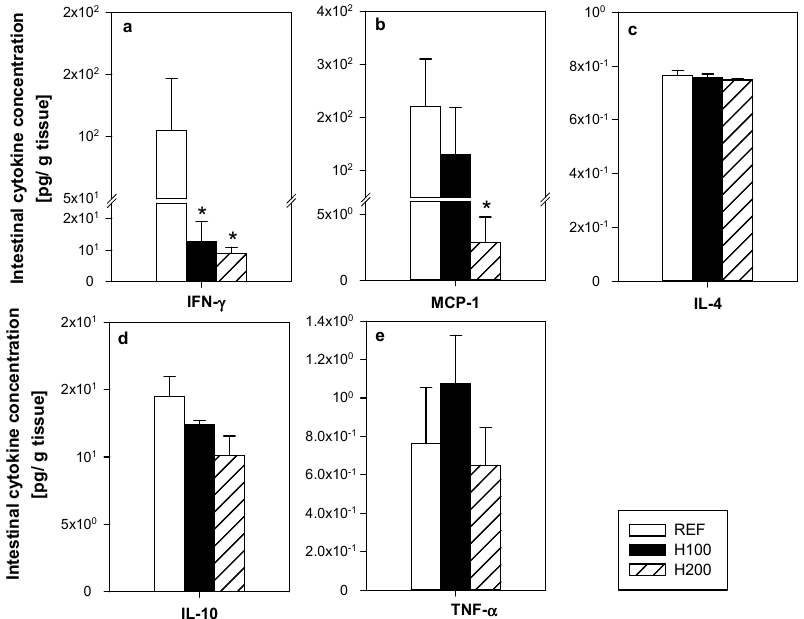
Figure 5. Effect of hesperidin administration on the cytokine concentration in the small intestine washes ( a – e ). Data are expressed as mean ± standard error ( n = 5–6). Statistical difference: * p < 0.05 versus REF group (Mann–Whitney U test).